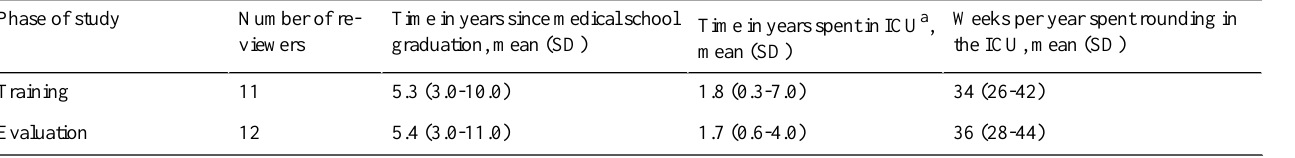
Table 1. Characteristics of reviewers.